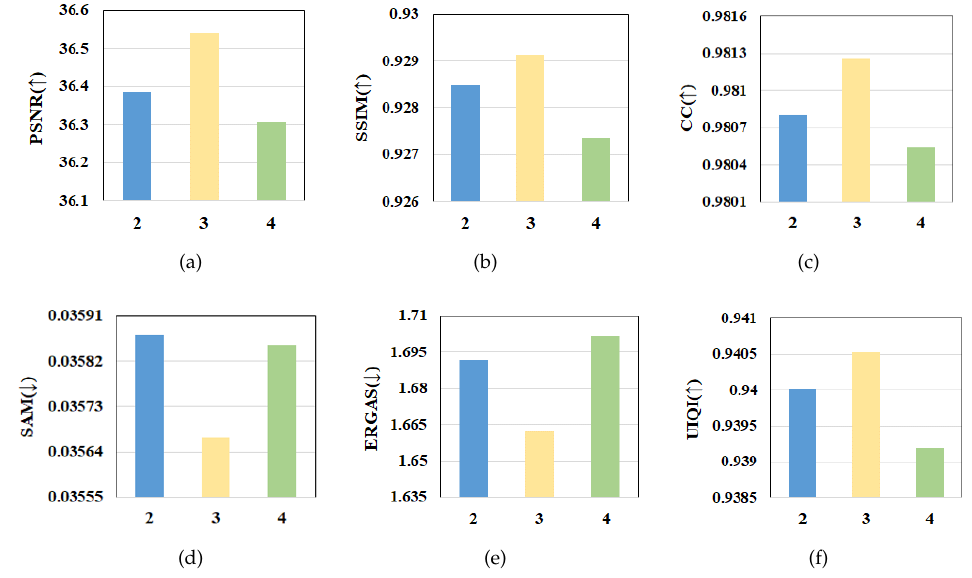
Figure 12. Average quantitative results for number of CSTBs on the QB datase. ( a ) PSNR. ( b ) SSIM. ( c ) CC. ( d ) SAM. ( e ) ERGAS. ( f ) UIQI. Table 8. Comparison of network parameters and training times under different number of CSBTs. Number of